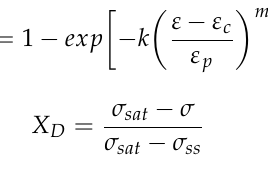
Figure 5. The recovery saturated stress calculation detail: ( a ) the polynomial fitting result; ( b ) the recovery saturated stress